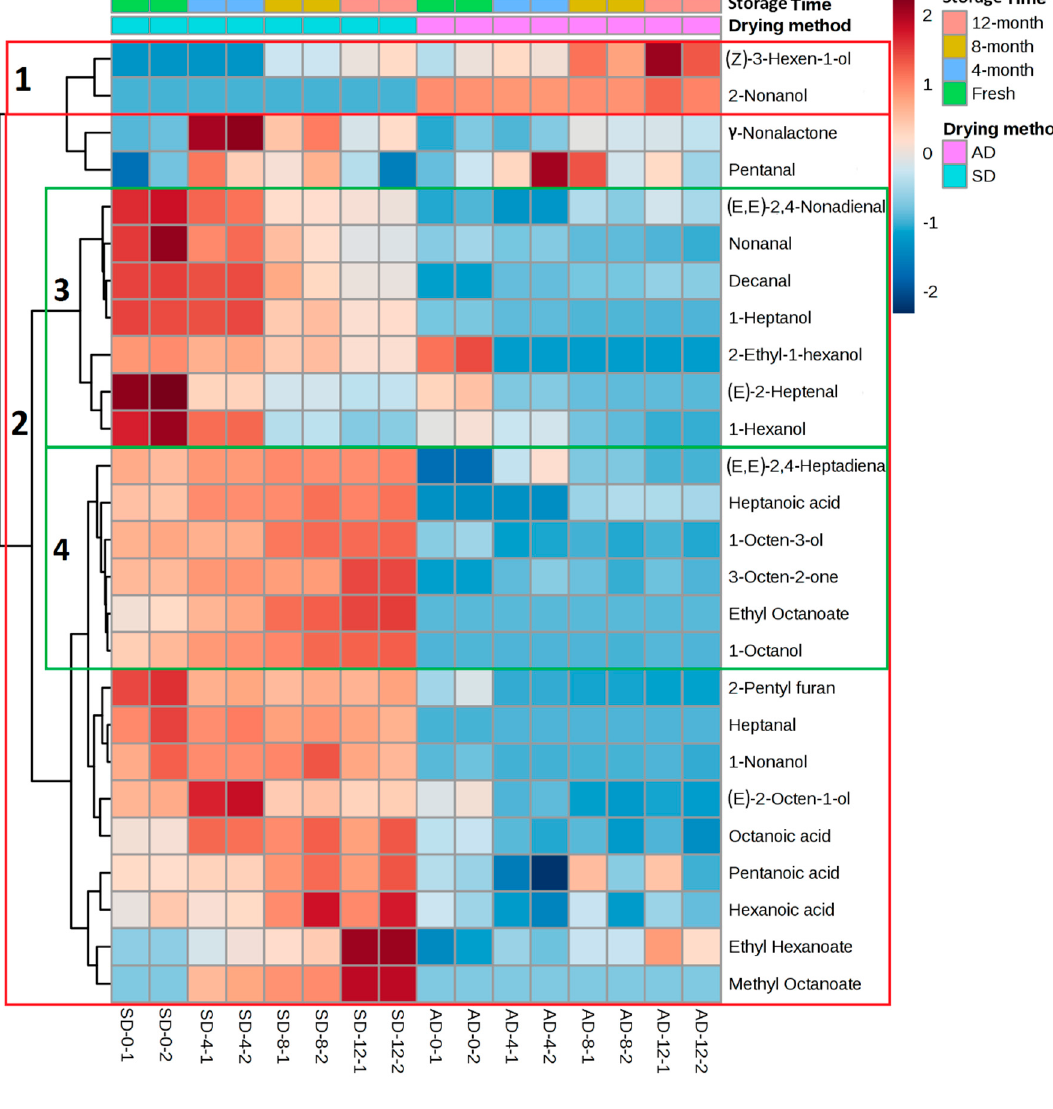
Figure 6. Heatmap visualization of fatty acid-derived volatile compounds of Thompson Seedless raisins.